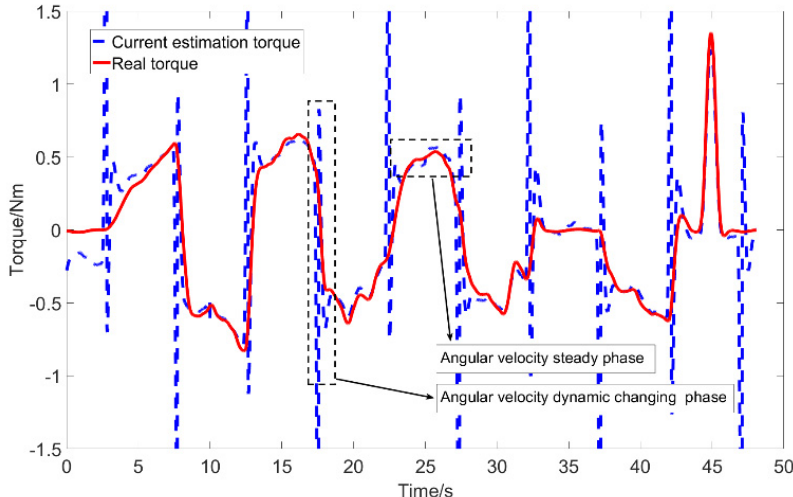
Figure 12. Comparison curve of current-based estimation torque and real torques. When the motor commutates or the angular acceleration is large, the output torque measured by the motor current has a large deviation from the real torque.